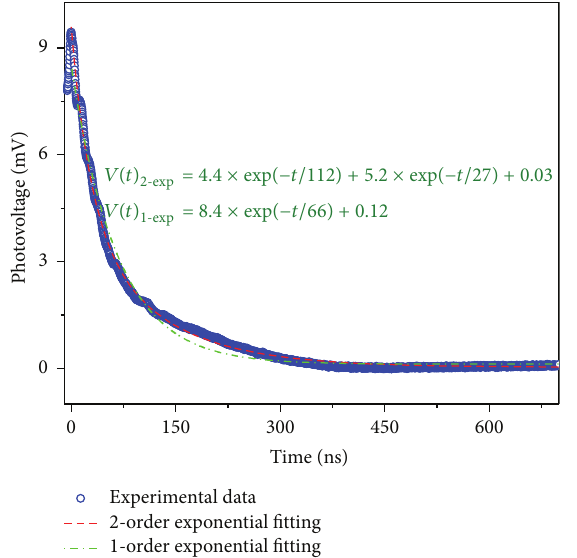
Figure 3: Photovoltaic profile of the detector illuminated by laser pulse.